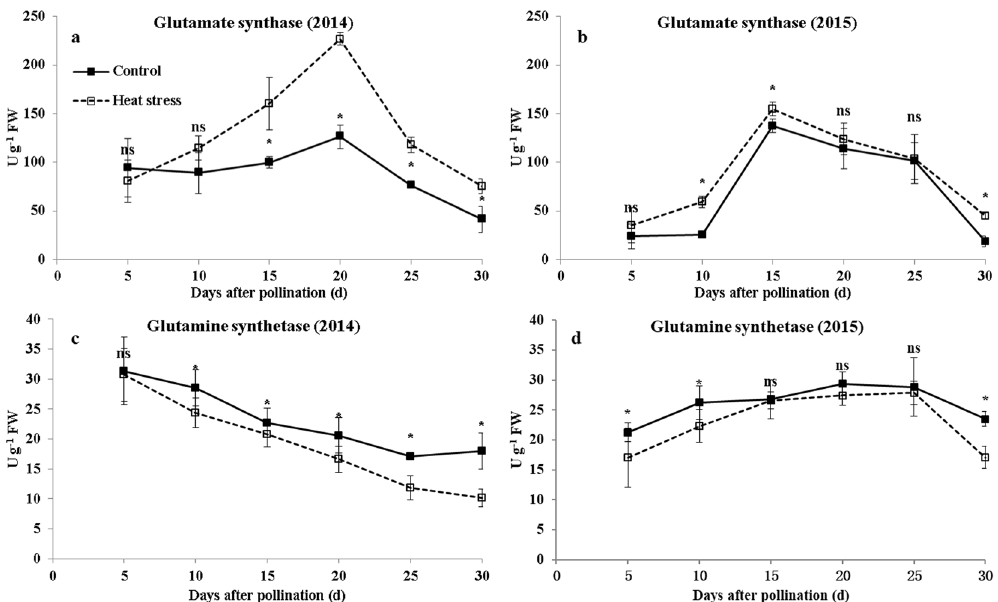
Figure 5. Activities of GOGAT and GS during grain filling under ambient and high-temperature conditions. ( a , c and b , d ) are the activities of GOGAT and GS in 2014 and 2015, respectively. Bars denote standard errors from three replicates, and one-way ANOVA was used to test for significance at p < 0.05